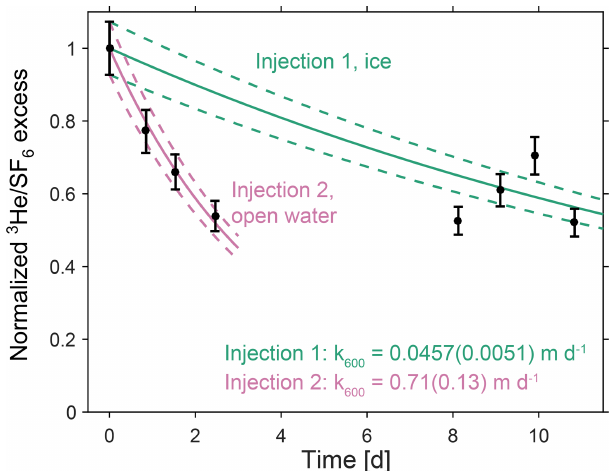
Figure 4. Measured and modeled excess tracer ratios. Measured and modeled ratio of excess 3 He / SF 6 , normalized to the initial mea- sured ratio for each injection. The modeled excess ratio is calcu- lated using the k 3 that minimizes error between the model and He measurements. Model results are shown for the model initialized with the initial measured concentration (solid lines), and starting 1 standard deviation above or below the measured initial concentra- tion (based on an error of 7.3% in the tracer ratio, dashed